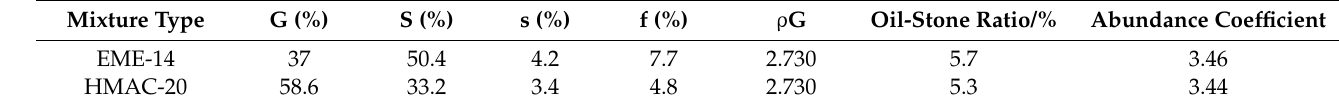
Table 5. Abundance coefficient calculation